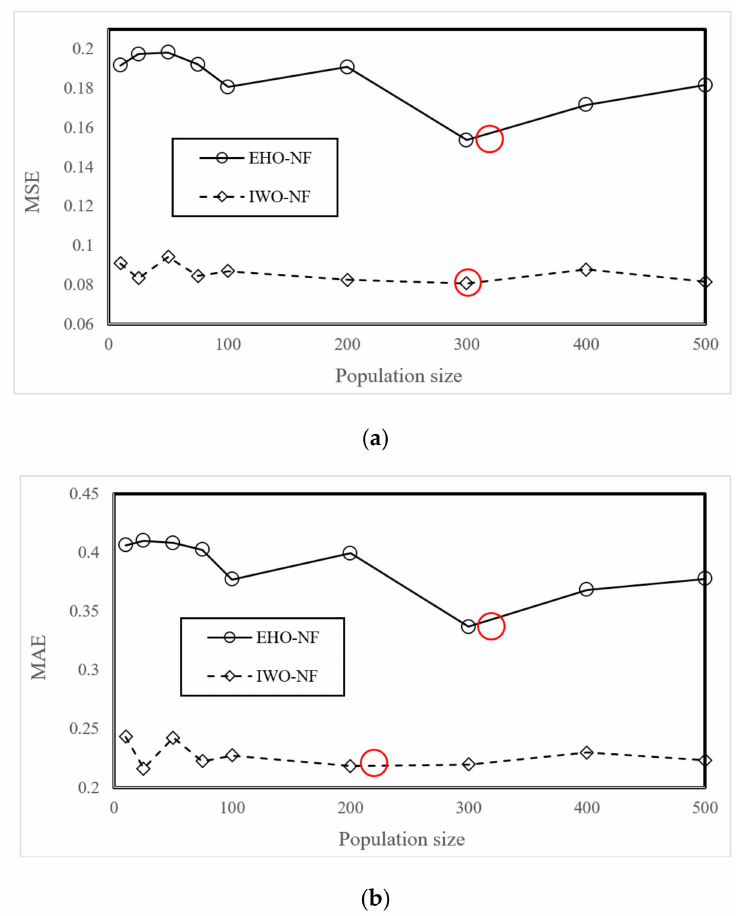
Figure 4. The results of the sensitivity analysis of the EHO-NF and IWO-NF based on ( a ) MSE and ( b ) MAE